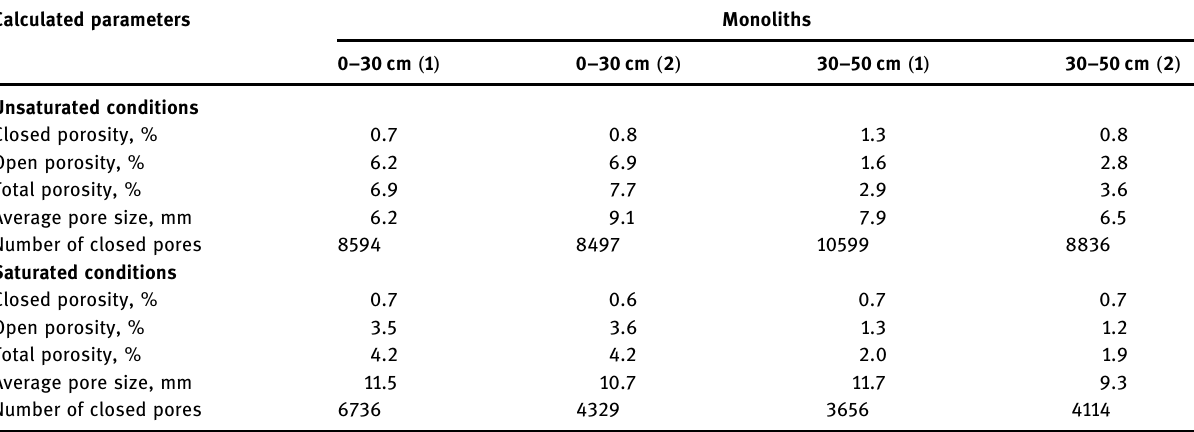
Table 3: 3D analysis of projections of tomographic images Calculated